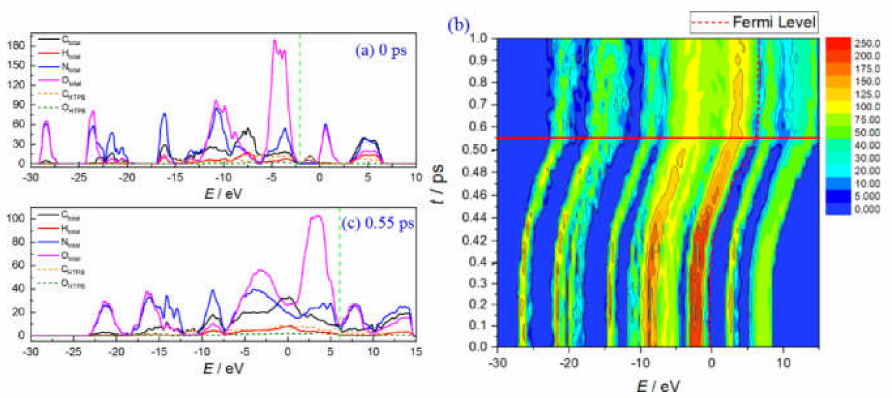
Figure 3. Density of states (DOS) for HMX(100)/HTPB composite: ( a ) at 0 ps, ( b ) DOS evolution, ( c ) at 0.55